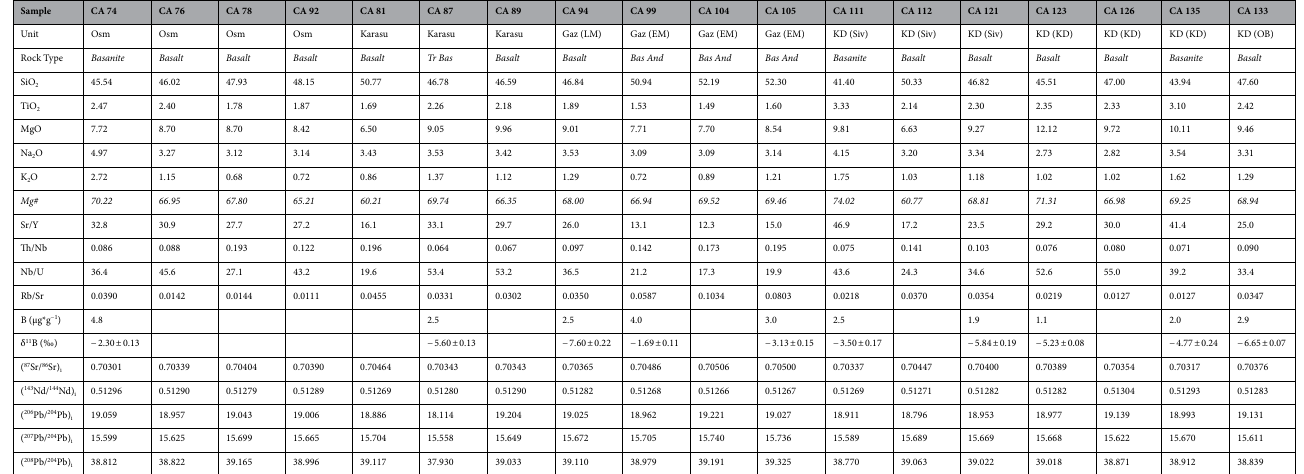
Table 1. Selected Major Elements (wt%), Trace Element Ratios, and Isotope Compositions of studied samples. Osm Osmaniye, Gaz Gaziantep, LM Late Miocene, EM Early Miocene, KD Karacadağ, Siv Siverek, OV Ovabağ, Tr Bas Trachybasalt, Bas And Basaltic Andesite. For δ 11 B (‰) values the 2σ in− run error is also reported. Full geochemical data available in Supplementary Table